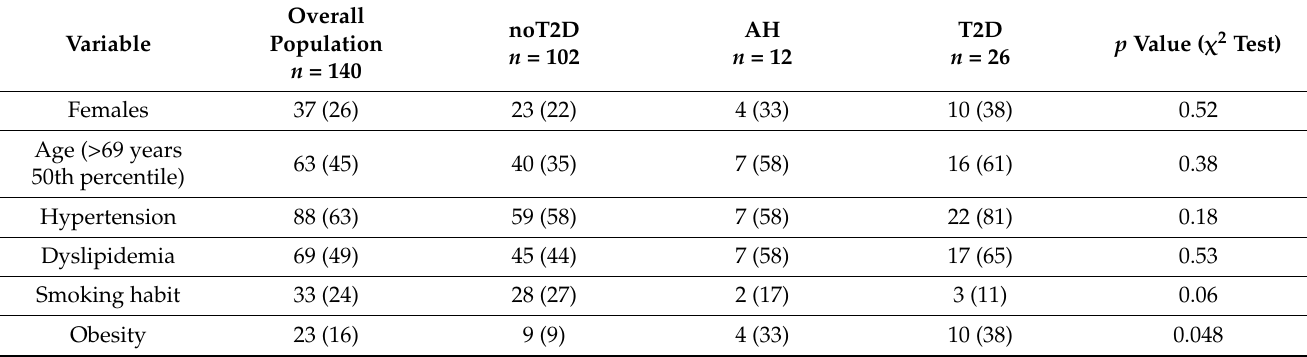
Table 1. Demographic, clinical, and laboratory parameters in the 140 AMI